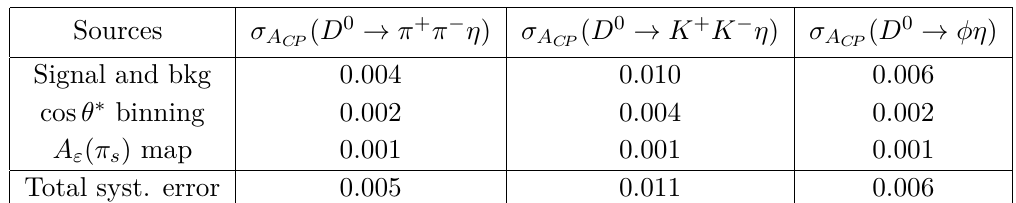
Figure 7 . CP -violating asymmetry A CP (top) and forward-backward asymmetry A FB (bottom) values as a function of cos θ ∗ ( D ∗ + ) for (a, d) D 0 → π + π − η , (b, e) D 0 → K + K − η , and (c, f) D 0 → φη , respectively. The solid red lines with a band region are the averaged values with their uncertainties. The dashed red curves in the A plots show the leading-order prediction for FB A FB ( e + e − → c ¯ c ) .